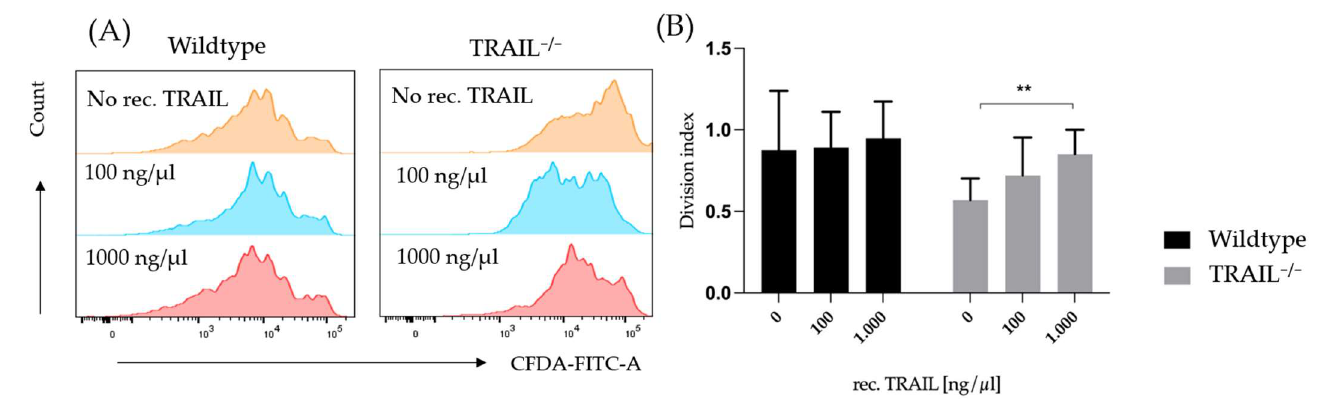
Figure 11. Effect of treatment with different concentrations of recombinant TRAIL (0, 100 and 1000 ng/μL) on CD3 + T-cell proliferation in TRAIL −/− and wildtype mice. ( A ) FACS histogram of prolifer- ation peaks. ( B ) Division index of CD3 + T-cells from TRAIL −/− mice versus wildtype C57BL/6 mice after TRAIL treatment in different concentrations ( n = 6–8 per group, two-way ANOVA, Tukey cor- rection test, ** p < 0.01). Graphs show mean ± SD.